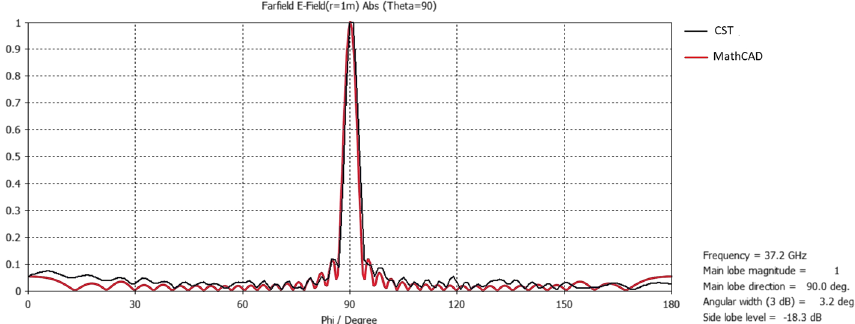
Fig. 12 Comparison of radiation patterns for antenna with non-identical irregularities obtained by numerical electromagnetic calculation and modified energy approach